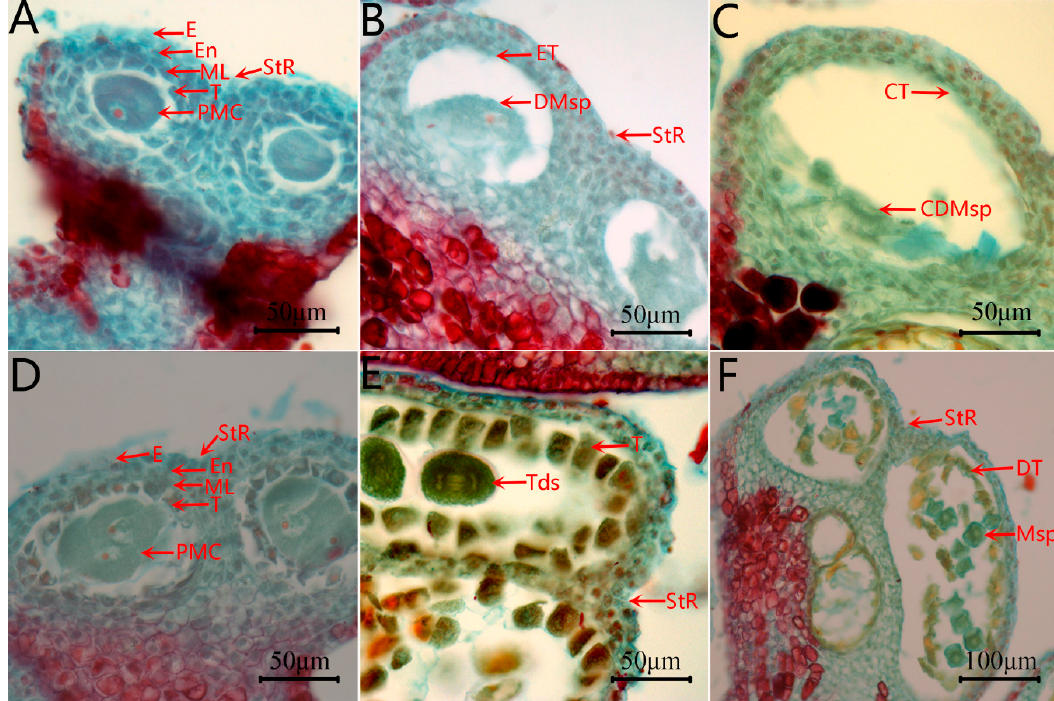
Figure 2. Phenotypic comparison between C2P5A and C2P5B at different development stages. ( A – C